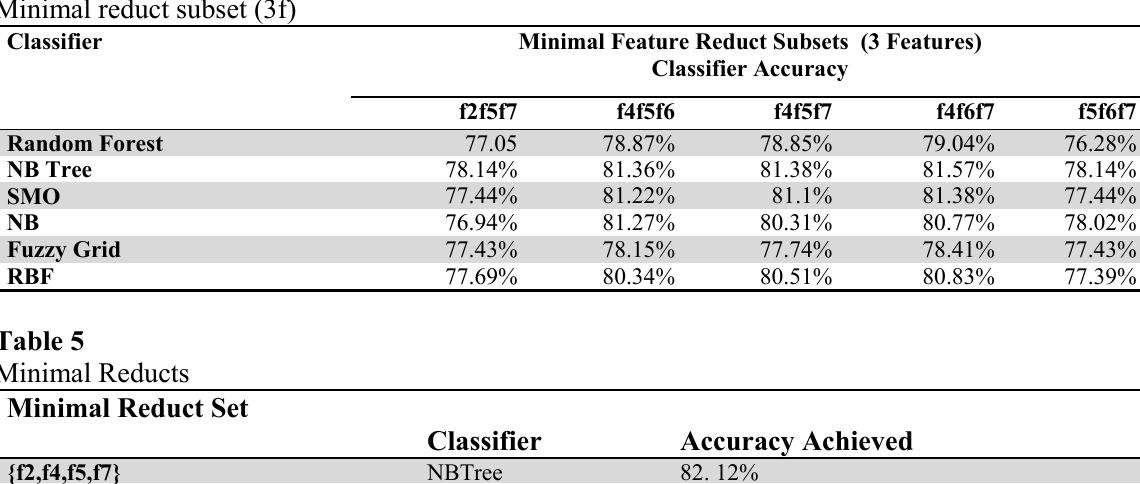
Minimal reduct subset (3f)